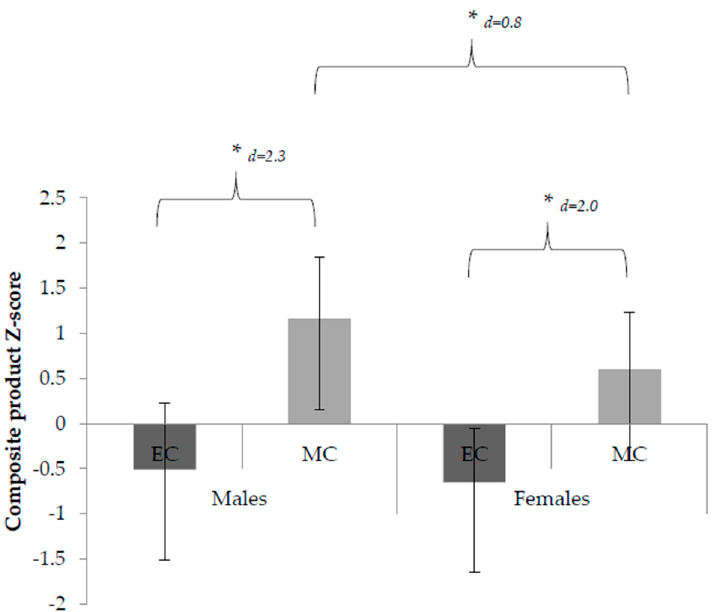
Figure 2. Composite product Z-score (mean ± standard deviation) of early-childhood (EC) and middle-childhood (MC) males and females. * Indicates significant difference between early-childhood and middle-childhood ( p < 0.05); * Indicates significant difference between males and females within a year group ( p < 0.05). Table 2. Component achievement (%) of locomotor skills during early-childhood (EC) and middle-childhood